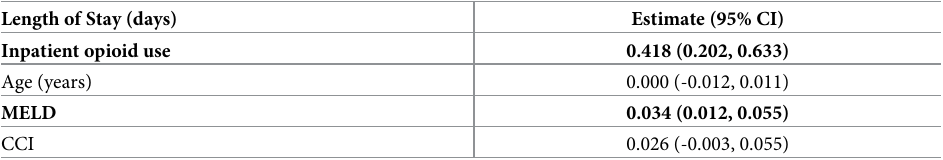
Table 8. Adjusted multivariable analysis of length of stay.